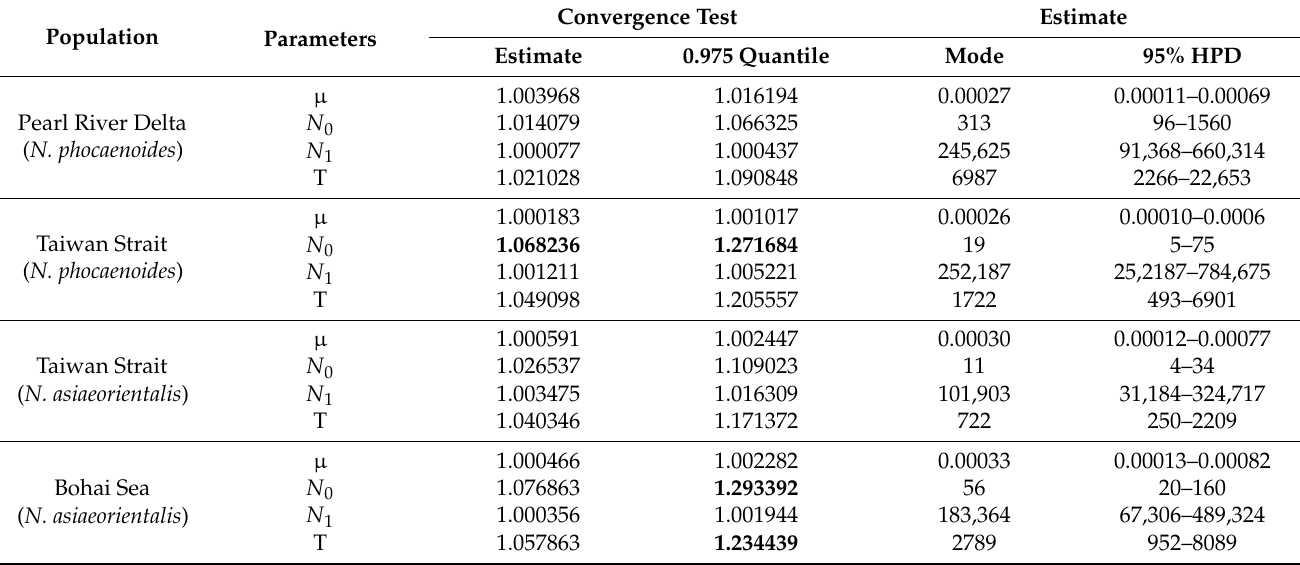
Table 2. Convergence test using Brooks, Gelman, and Rubin diagnostics, the mode value and 95% Highest Posterior Density (HPD) distribution of demographic parameters, including the mutation rate ( µ ), current effective population size ( N 0 ), effective population size before the demographic change ( N 1 ), and time (T) of the demographic event (years before present) estimated with MSVAR simulations. Parameters with signs of non-convergence are indicated in bold. Narrow-ridged